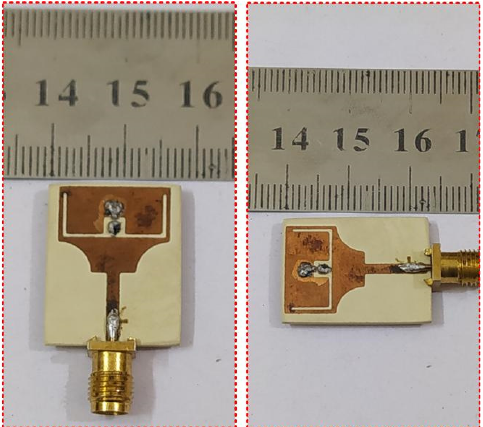
Figure 8. Fabricated prototype of the proposed antenna.